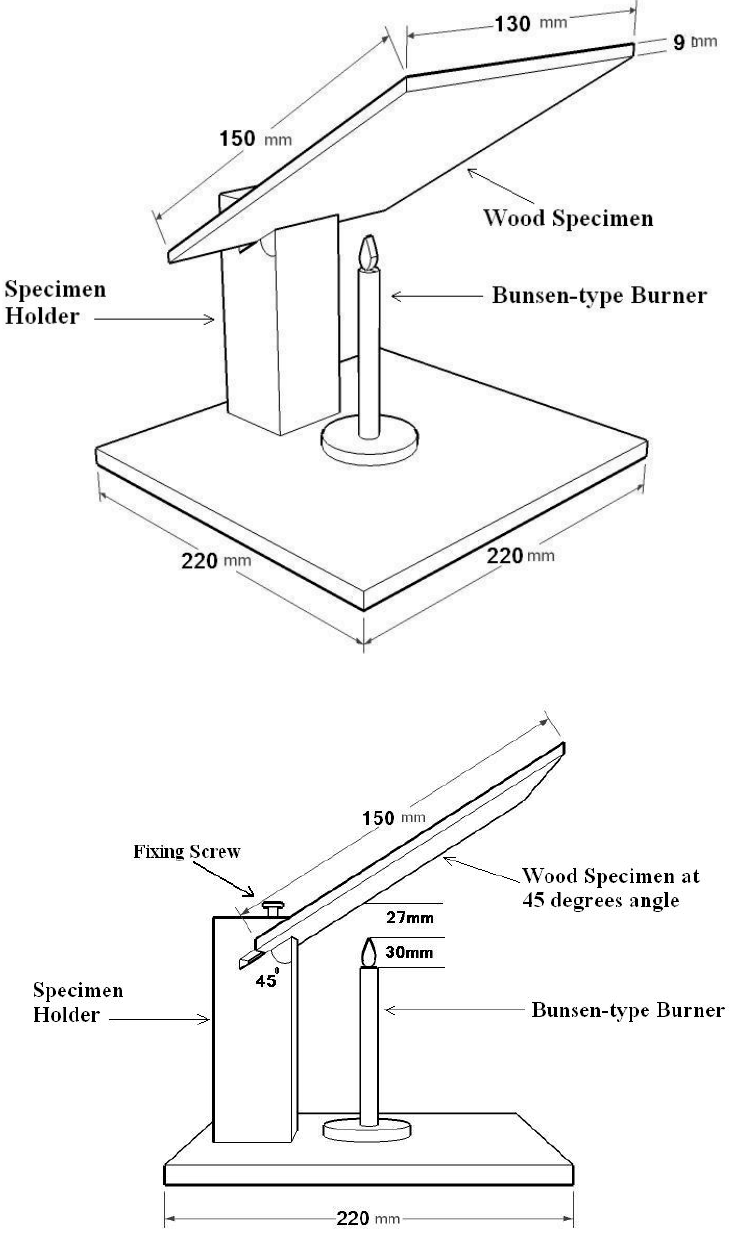
Figure 1. Schematic picture of fixed fire testing apparatus (Iranian Patent No. 67232; approved by Iranian Research Organization for Science and Technology under license No. 3407; USPTO Pub. No.: US 2019/0212283 A1) [38,43].